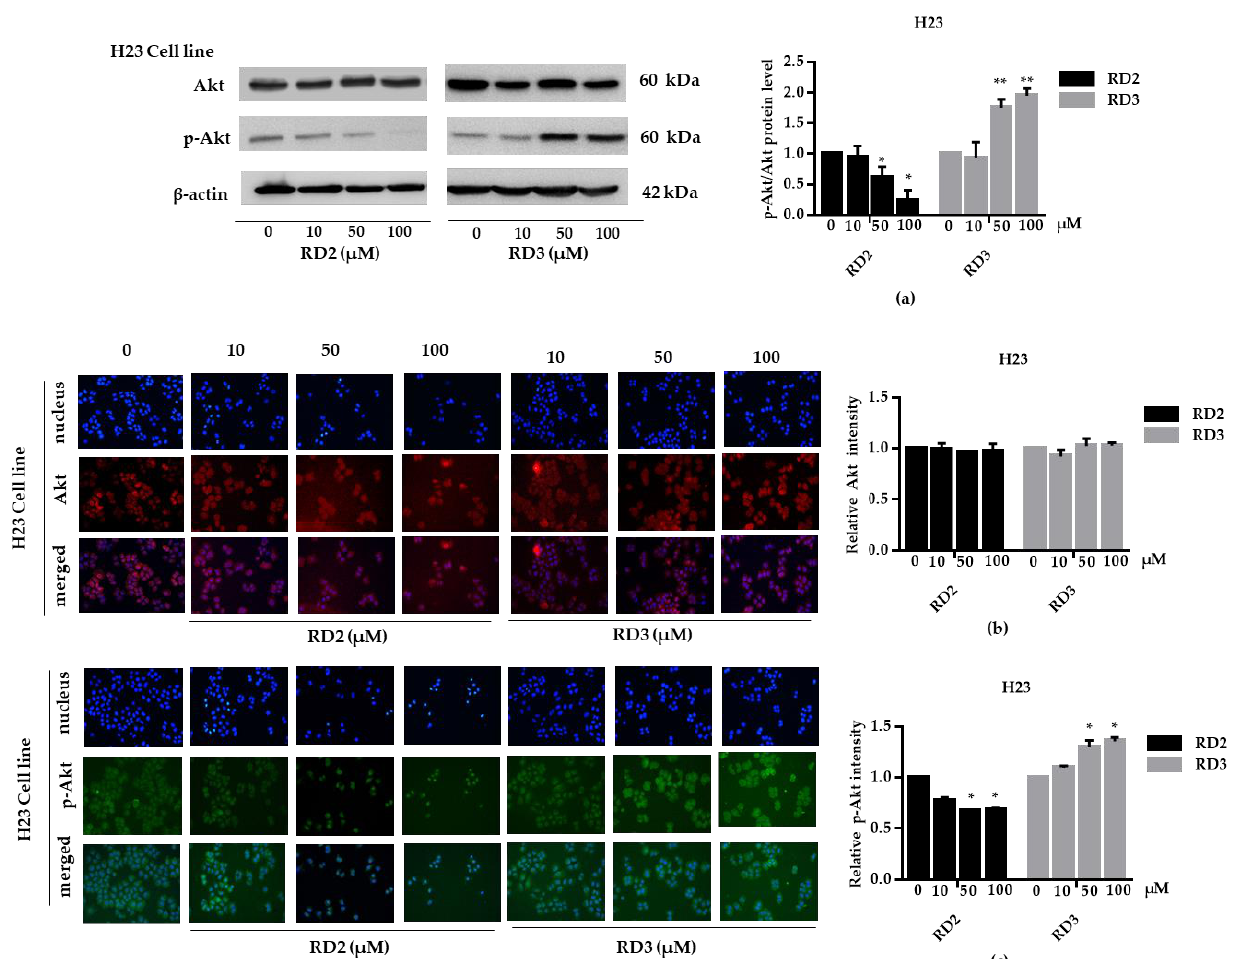
Figure 8. RD2 downregulates p -Akt in NSCLC cells (H23). The cells were treated with RD2 and RD3 (0 – 100 μM ) for 24 h. ( a ) Western blot analysis was performed to measure the p -Akt/Akt-related proteins. β -Actin protein was evaluated to confirm the equal loading of each protein sample. Densitometry of each protein level was calculated and the results are presented as a relative protein level. ( b ) A549 cells were stained with Akt (red fluorescence) and Hoechst 33342 (blue fluorescence). The expression of Akt was determined by immunofluorescence. ( c ) H23 cells were stained with p -Akt (green fluorescence) and Hoechst 33342 (blue fluorescence). The expression of p -Akt was examined using immunofluorescence. Relative protein levels were quantified by densitometry. Data are represented as the mean ± SEM. * p < 0.05, ** p < 0.01, when compared with the control